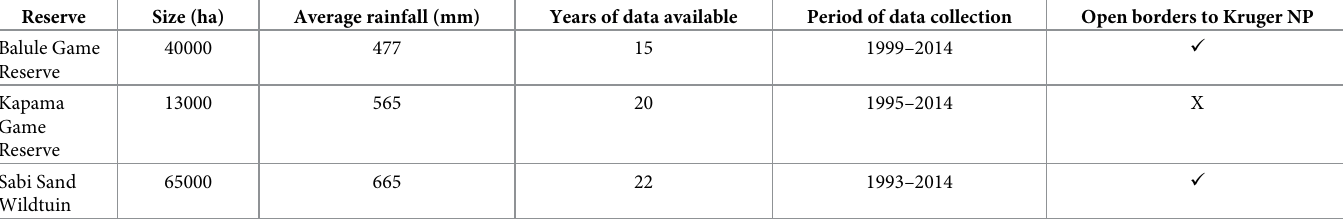
Table 1. Overview of characteristics of the different research areas, with the name and size of the reserve, the average rainfall per year, the number of years from which complete data is available for analysis, and whether the reserve has open borders to Kruger National Park. Reserve Size (ha) Average rainfall (mm) Years of data available Period of data collection Open borders to Kruger